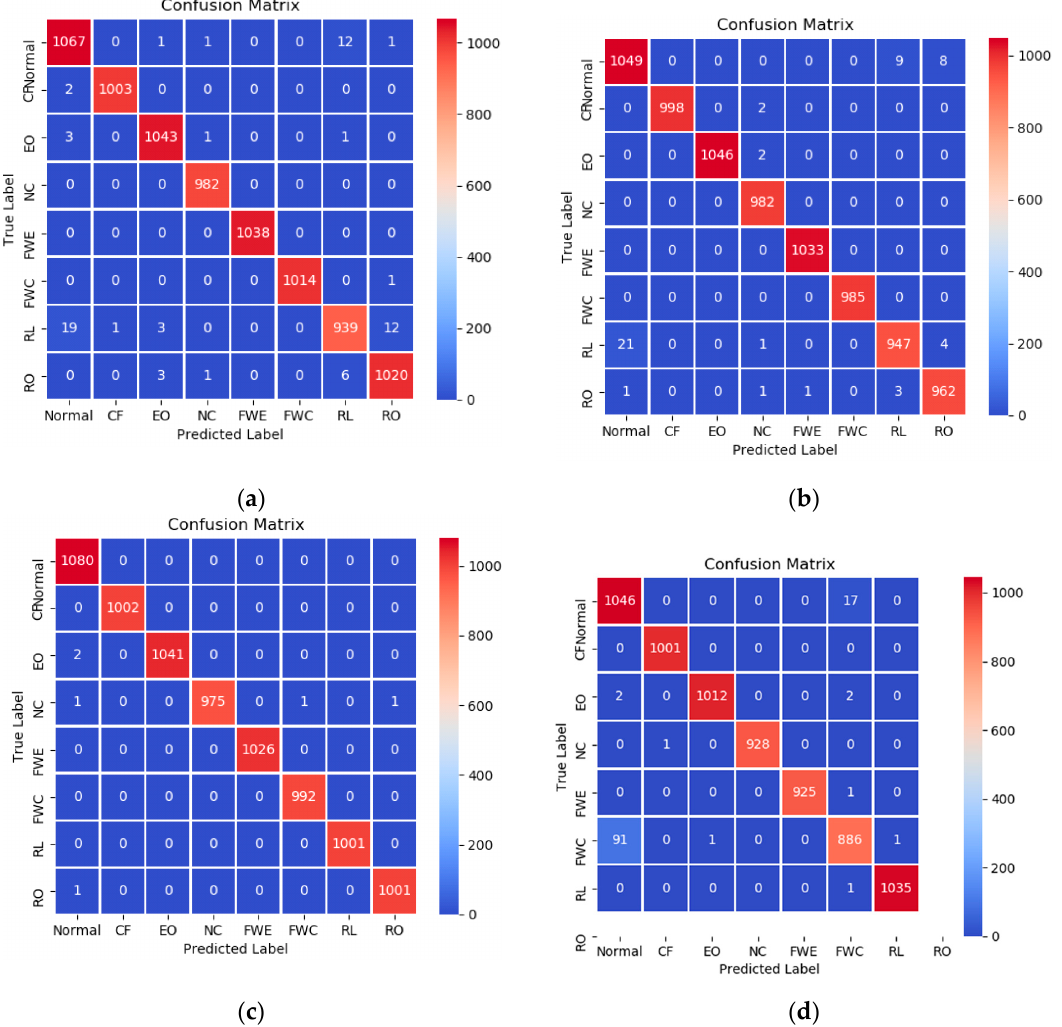
Figure 13. The confusion matrix with different fault level with fault severity ( a ) level I , ( b ) level II , ( c ) level III , and ( d ) level IV .